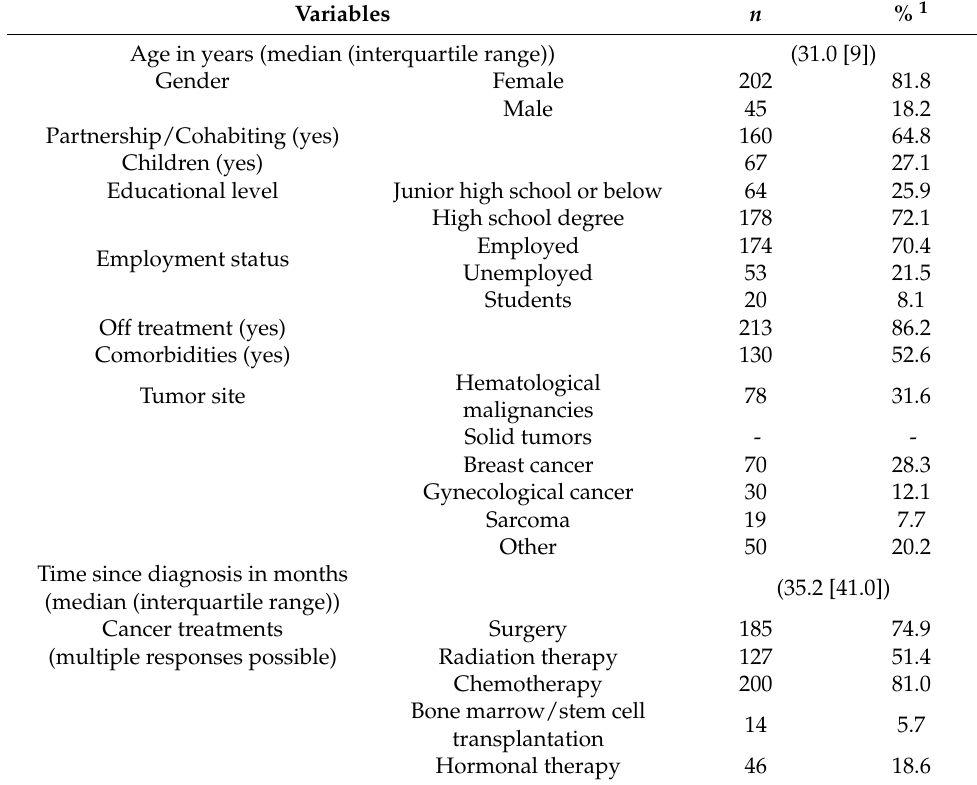
Table 1. Sample demographic and medical characteristics ( n =